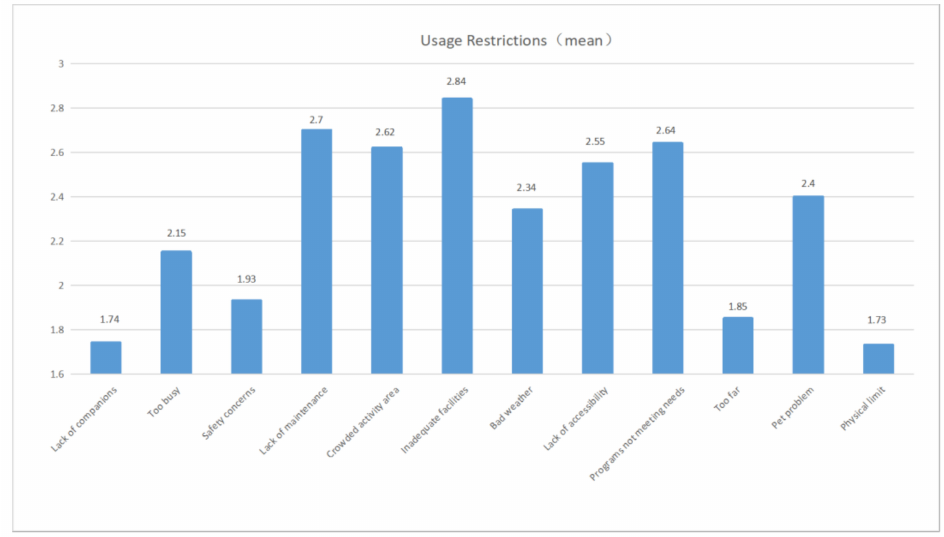
Figure 4. The respondents’ constraints in using green spaces in an old residential